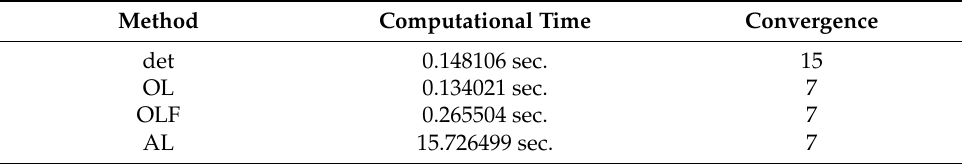
Table 2. Computational aspects of optimal control for the ATOPT